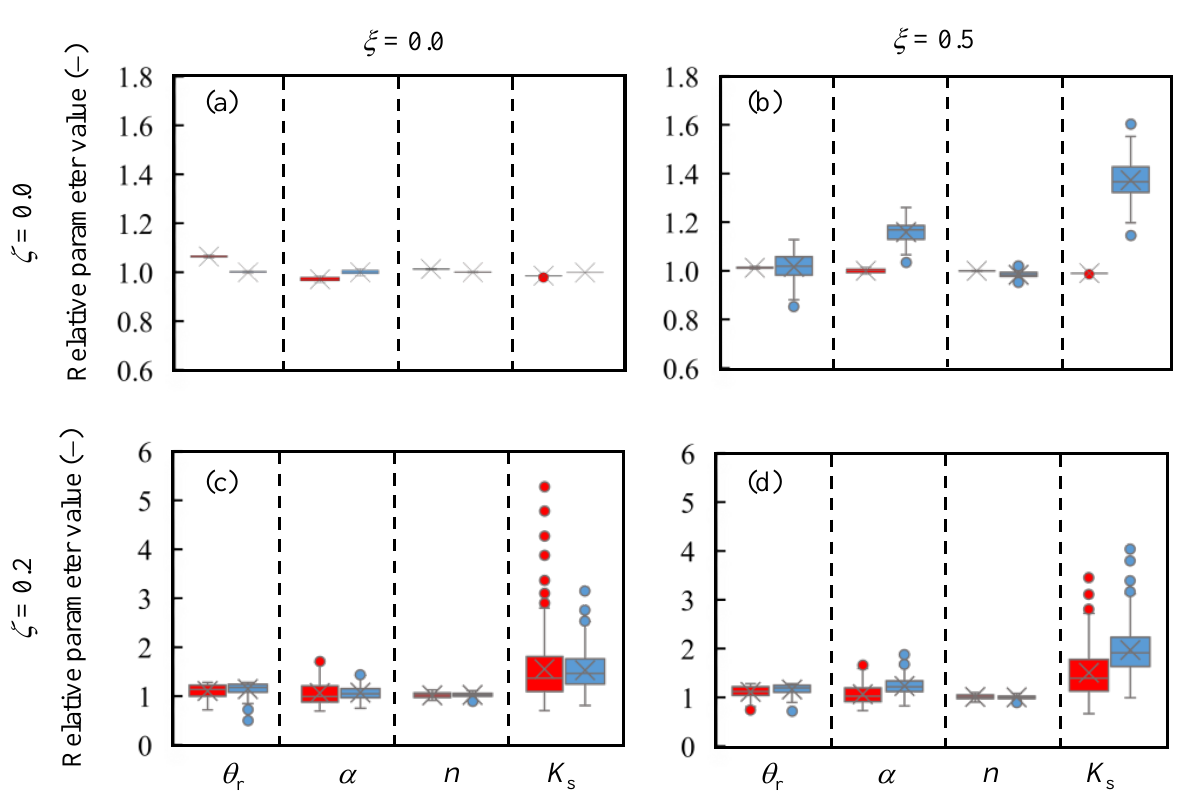
Figure 6. Box diagrams of the inversion parameters obtained from the SO (red) and MO (blue) approaches for the loam example: ( a ) both ξ and ζ are zero; ( b ) ξ = 0.5 and ζ = 0.0; ( c ) ξ = 0.0 and ζ = 0.2; ( d ) ξ = 0.5 and ζ = 0.2. ξ is the relative oscillation level of the evaporation rate. ζ is the relative level of observation